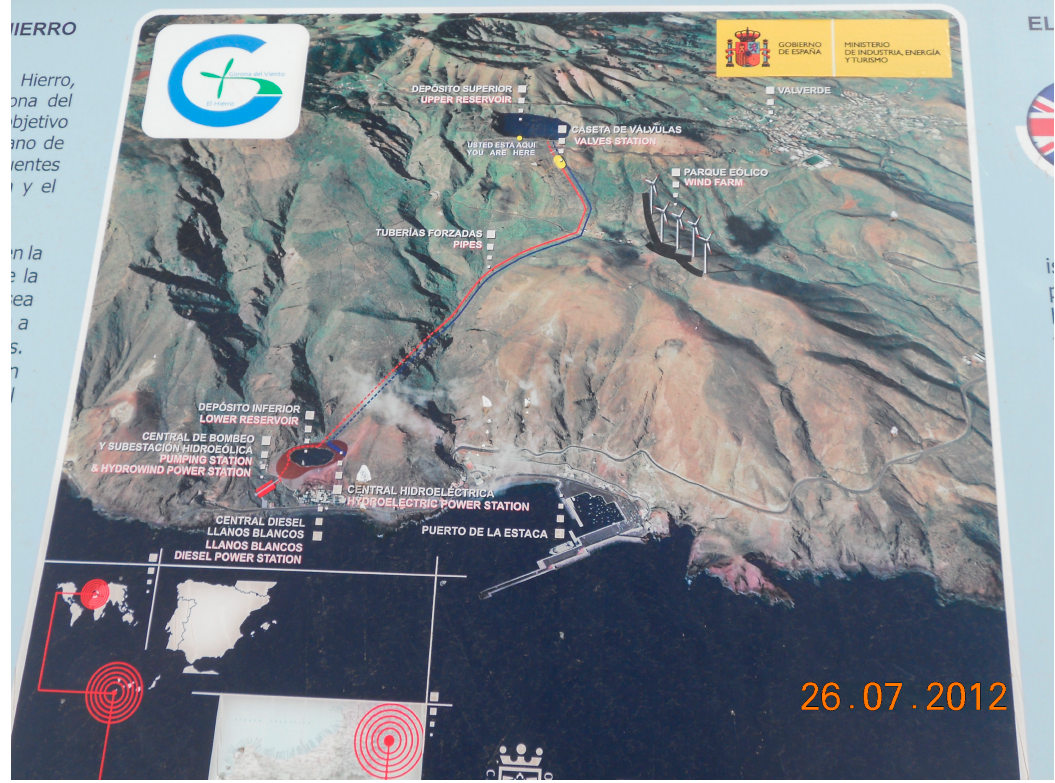
Figure 4. Information board presenting implementation of the Gorona del Viento Project with planned location of the objects. Photo: G. Jastrz ę bska.